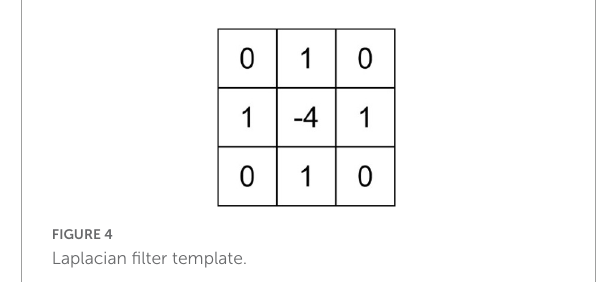
FIGURE4 Laplacian filter